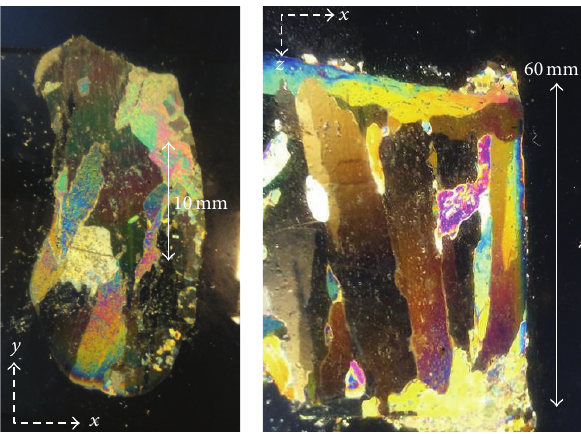
Figure 1: Ice thin sections in the 𝑥 - 𝑦 plane and in the 𝑥 - 𝑧 plane, showing a columnar